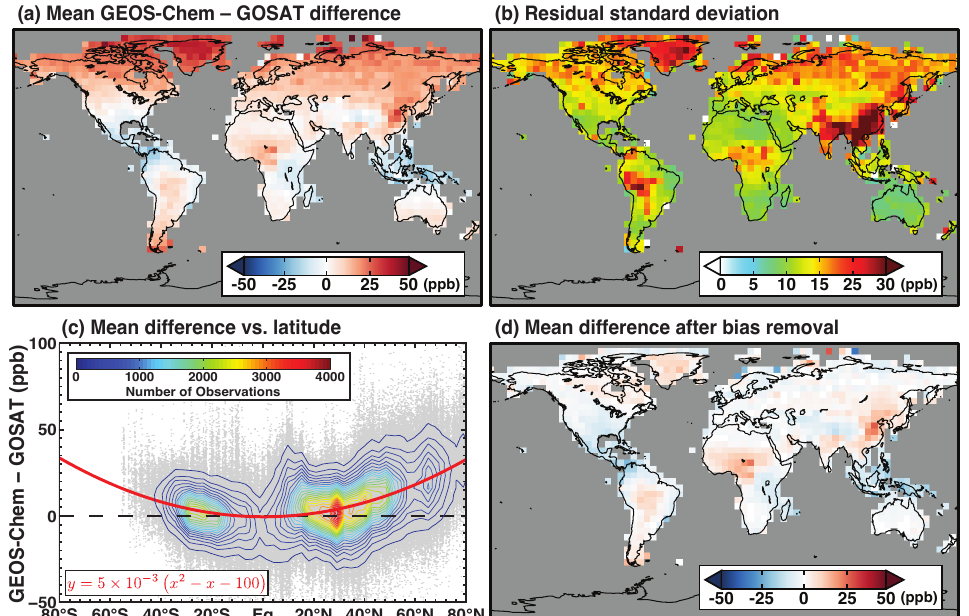
Figure 2. Comparison of the GOSAT observations from Fig. 1 to the GEOS-Chem model with prior emissions. (a and b) show the mean bias and residual standard deviation for the model–satellite difference. (c) shows the model–satellite difference as a function of latitude for individual observations along with the data density (contours), and a quadratic regression (red line; x in degrees latitude, y in ppb) as an estimate of the bias. The regression excludes grid squares with residual standard deviation in excess of 20ppb as model bias in prior emissions could dominate the difference. (d) is the same as (a) but using the bias correction from (c) .